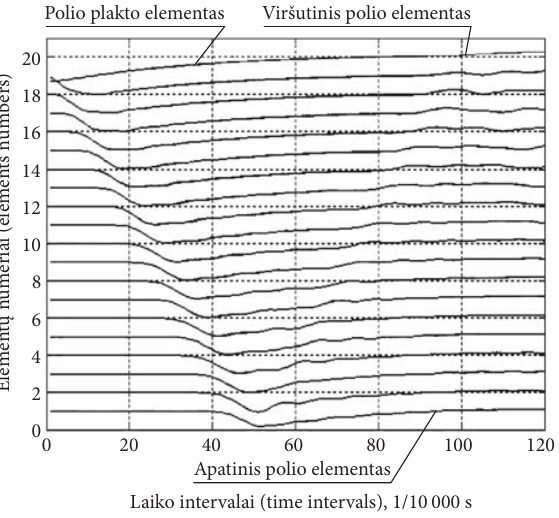
Fig. 4. Idealizated segments displacements of pile scheme versus time